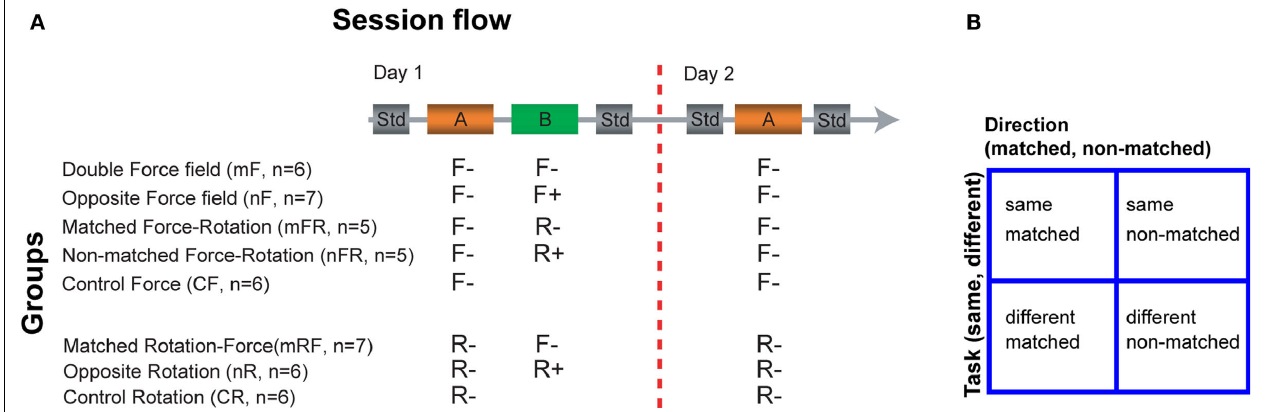
FIGURE 1 | Groups and block structure. (A) The sequence of trial blocks is shown for the 2-day sessions in which all subjects participated. Subjects were assigned to one of eight groups. Each day-session started and ended with a standard block (Std). Except for two control groups (control force (CF) and control rotation (CR) groups), all subjects performed two tasks (A and B) on day 1. The tasks in each group (listed